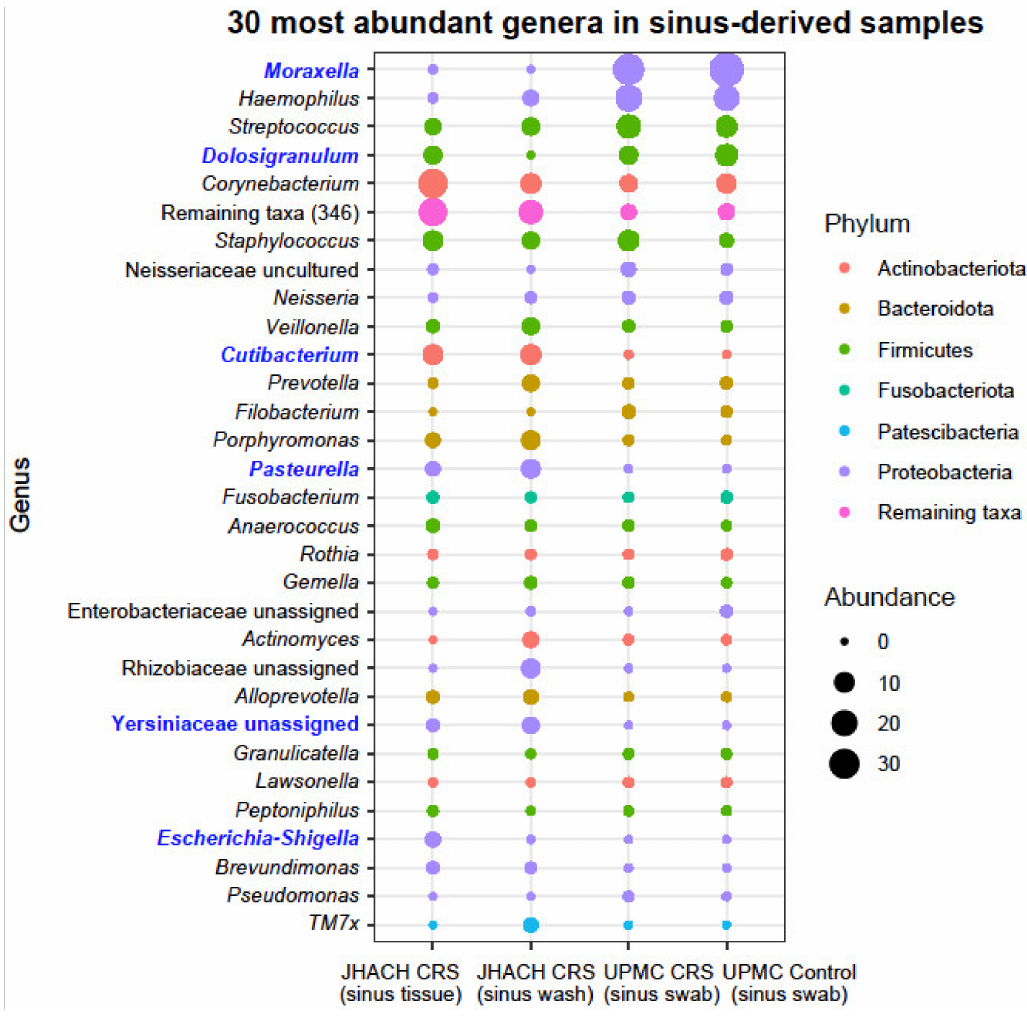
Figure 6. Mean abundances of the 30 most abundant genera in the sinus-derived sample from chronic rhinosinusitis (CRS) and healthy participants in the Johns Hopkins All Children’s Hospital (JHACH) and/or University of Pittsburgh Medical Center (UPMC) cohorts. Differentially abundant genera across sample subgroups are indicated in